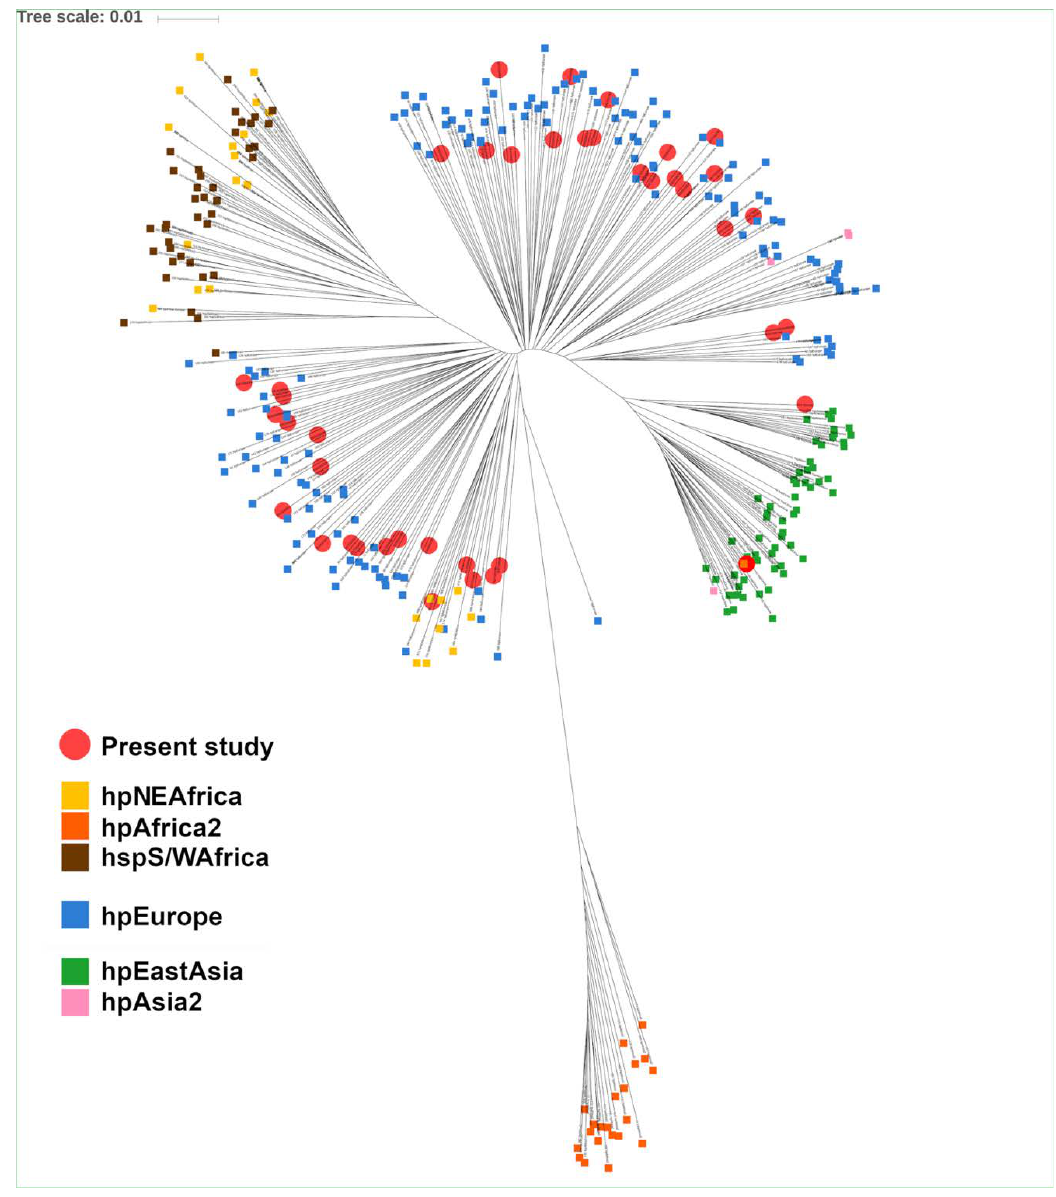
Figure 1. Phylogenetic analysis of the 41 H. pylori strains isolated from non-atrophic gastritis patients (Neighbor-joining tree-Kimura 2-parameter). Isolates representative of H. pylori populations are identified with colored squares and were retrieved from PubMLST. H. pylori isolates included in the present study are highlighted with red circles, and cluster mainly (95%) with hpEurope, but also with hpEastAsia (5%).